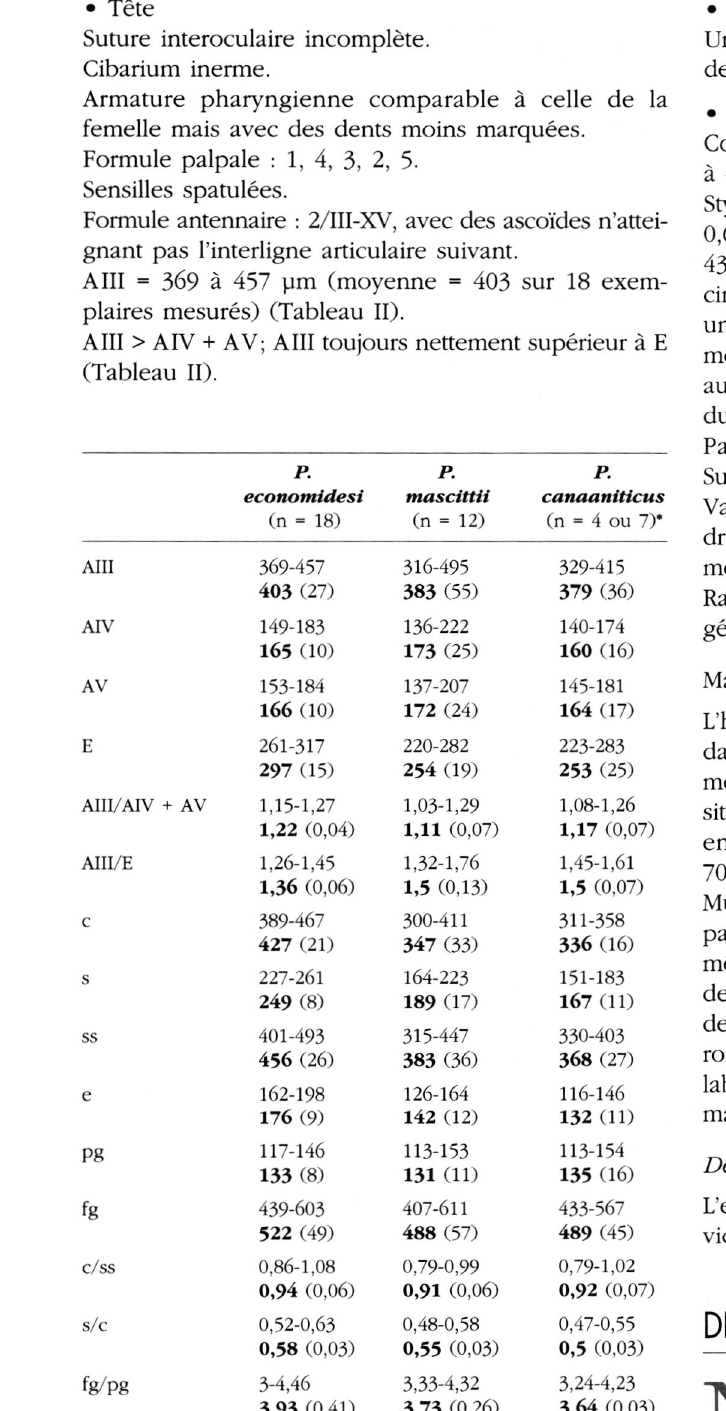
Tableau II. - Mensurations comparées chez les mâles de P. econo midesi (n = 18; origine : locus classicus), P. mascittii (n = 12; ori gine : Auvergne (11) et Italie (un cotype)) et P. canaaniticus (n = 7; origine : Liban (6) et Israël (un syntype)). Pour chaque organe mesuré sont indiqués les valeurs minimale et maximale, la moyenne (en caractères gras) et l'écart-type (entre parenthèses). E =